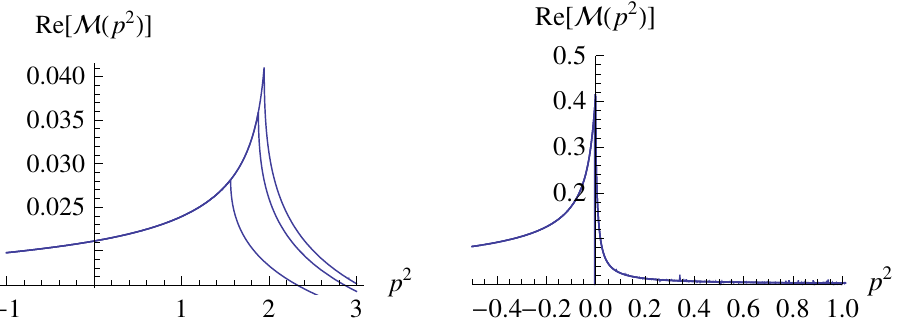
Figure 22 . Three-dimensional LW fakeon: numerical results from the nonanalytic Wick rotation with no domain deformation for (right